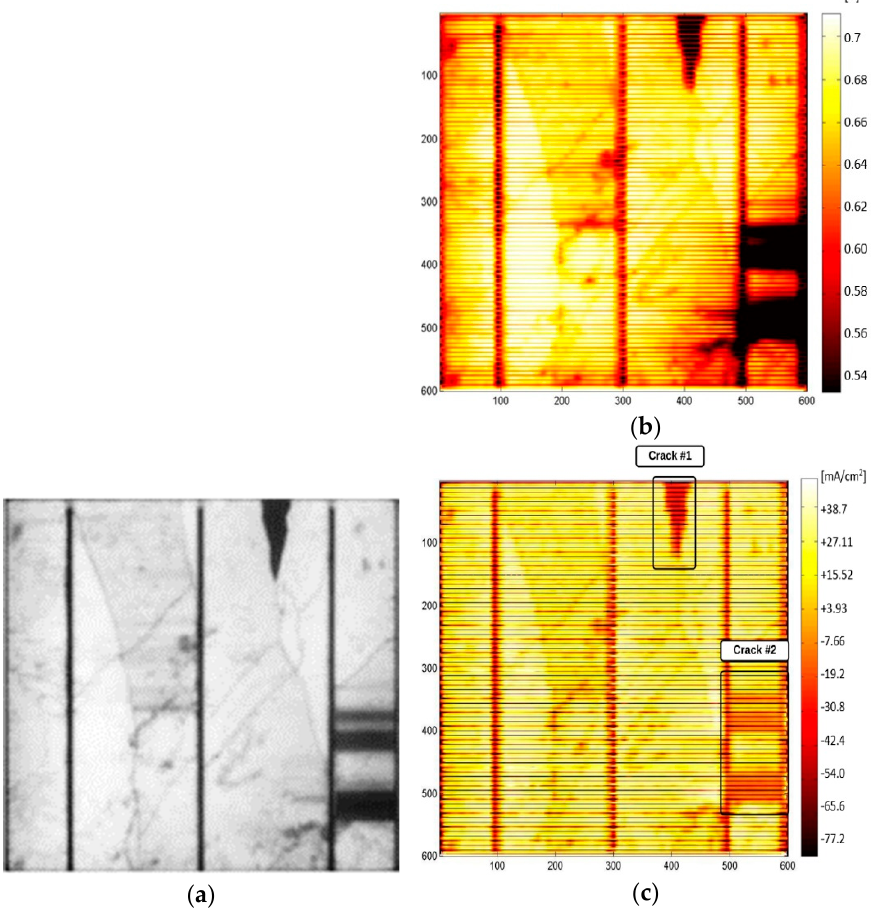
Figure 11. Solar cell affected by a nonuniform distribution of cracks [73]: ( a ) EL image; ( b ) Voc; ( c ) Jsc maps.